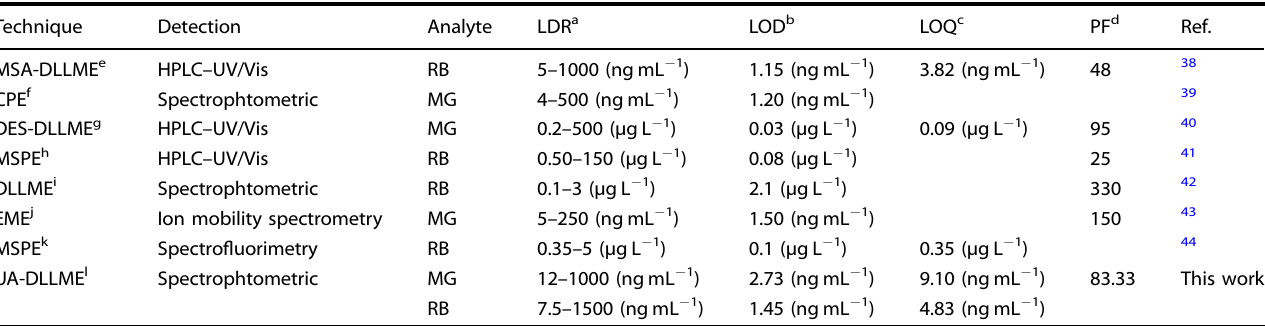
Table 3. Comparison of different methods for extraction of RB and MG dyes with developed methods.